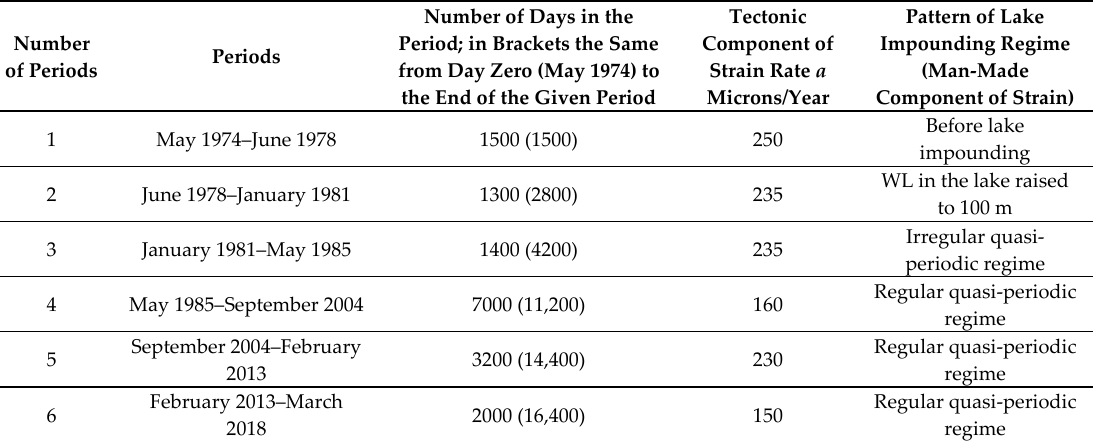
Table 1. Periodization of the fault zone extension.